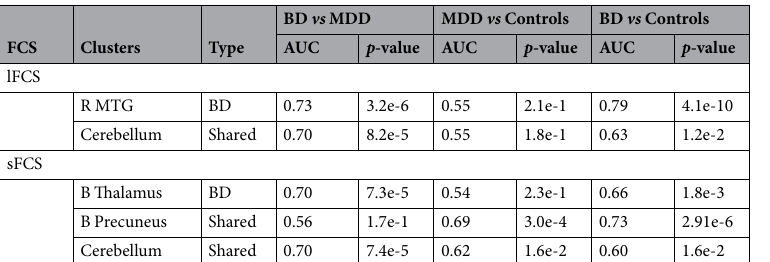
emotional tasks 43–45 . Furthermore, other studies found normalized function in the precuneus/PCC in depressive patients following treatment with antidepressant medications 46 or cognitive behavioral therapy 47 . Taken together, the finding of decreased sFCS in the precuneus suggests that disturbed functional connectivity in the precuneus/ PCC could partially contribute to impaired integration of emotion and memory in BD and MDD patients in a depressive episode. Although the cerebellum is primarily thought to modulate movement, in fact regions of the cerebellum are closely interconnected with the frontal cortices and limbic system 48 , suggesting that it plays a role in the regu- lation of emotion, affect, and cognitive processes 49, 50 . This study identified increased lFCS and sFCS in the BD patients, but decreased lFCS and sFCS in the MDD patients in the cerebellum (including the anterior, posterior,